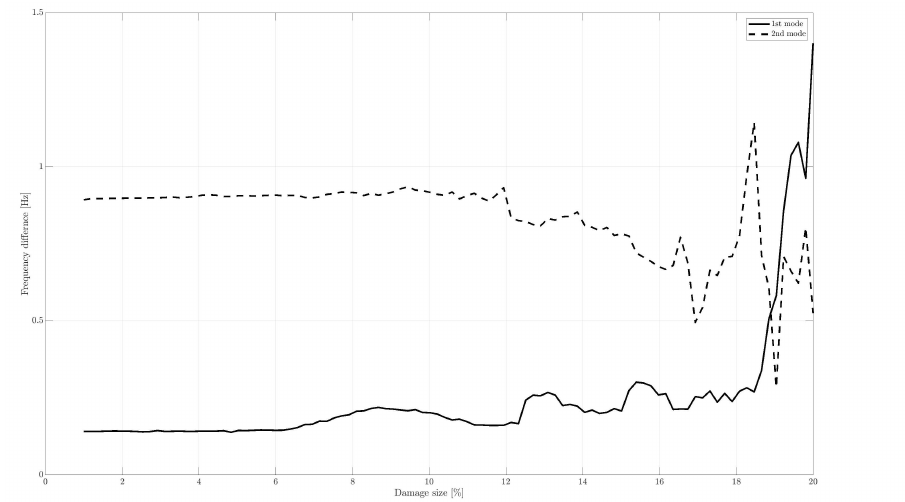
Figure 3. The impact of delamination size on frequency difference of damaged and undamaged samples for the 1st and 2nd modes.